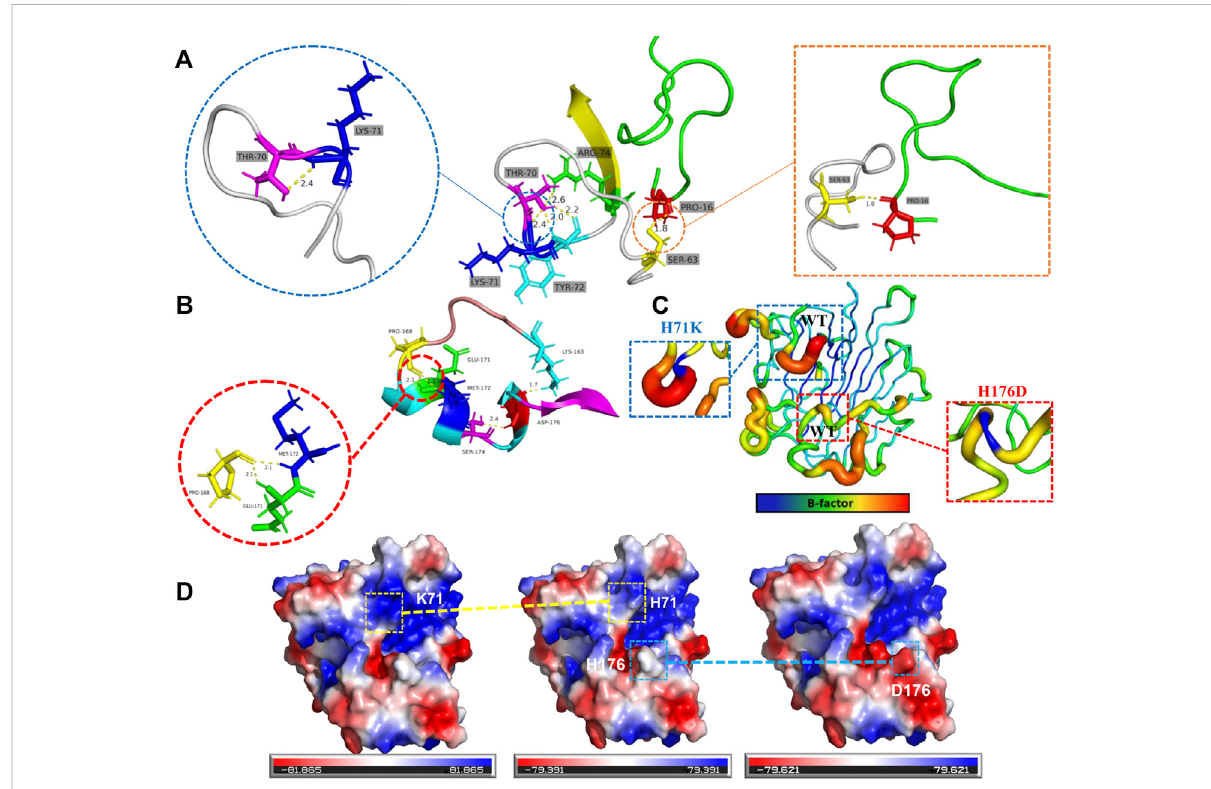
FIGURE 5 Structural analysis for mutational effects on the thermostability of mutants. Potential hydrogen bonding interactions caused by mutants H71K (A) and H176D (B) are indicated by yellow dashed lines. (C) The effect of mutation on protein B-factor. (D) Changes in surface electrostatic charge distribution caused by mutations. The structures shown are H71K, WT, and H176D from left to